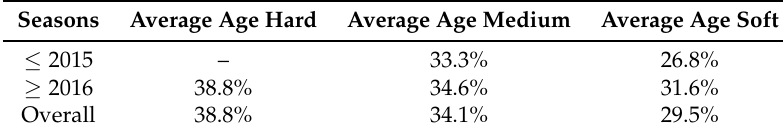
Table 3. Comparison of the average tire age (normalized by race length) when tires are changed, depending on the relative compound and season. The values apply to data filtered according to Section 3.2.2.